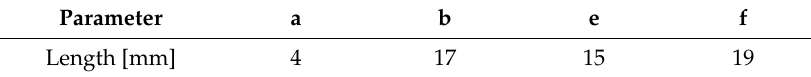
Table 1. Design parameters from kinematic calculations in Figures 5 and